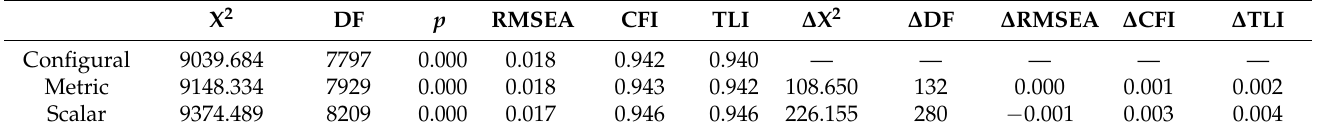
Table 10 shows invariance analysis by ancestry (the categories are: non-Mapuche; unknown; Mapuche), which shows that the differences in RMSEA, CFI and TLI do not show relevant changes in fit. This affirms that the data meets configural, metric and scalar invariance, which occurs in the same way in the invariance analysis for sex, school type, payment, grade and age range (Table 11). Table 10. Measurement invariance test based on ancestry. Source: prepared by the authors.